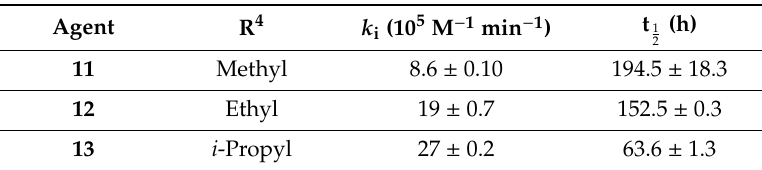
Table 2. Chemical structure of tested organophosphorothioates, AChE inhibition kinetics ( k i ) and stability in human plasma (t 1 ).